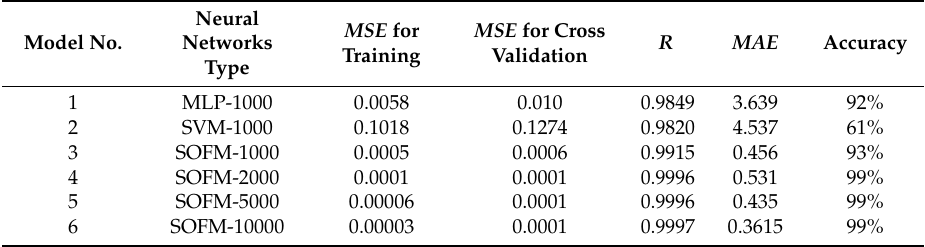
Table 2. The comparison results of MSE in training and cross-validation, mean absolute error ( MAE ), R , and accuracy for multi-layer perceptron (MLP), support vector machine (SVM) and SOFM models.